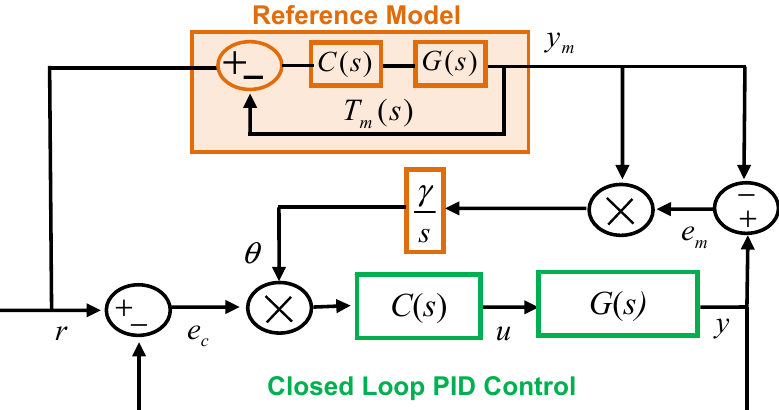
Figure 6. Block diagram of the ML-MR PID-MIT with controller gain modification (ML-MR PID-MIT-CGM) control structure and numerical realization of the reference model.